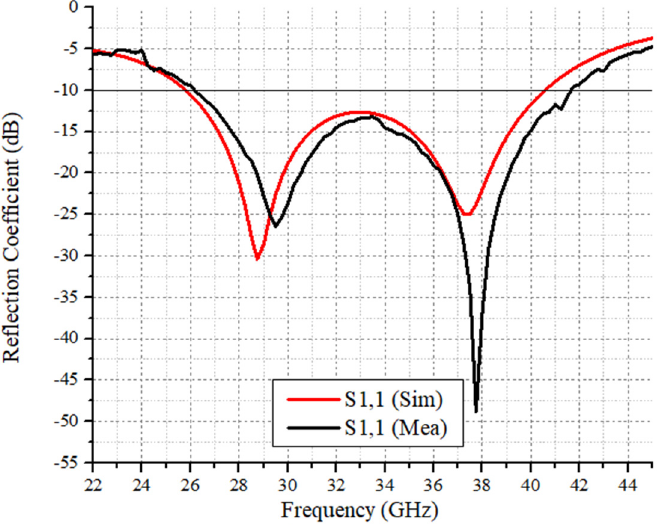
Figure 3. Single element simulated and measured reflection coefficient.